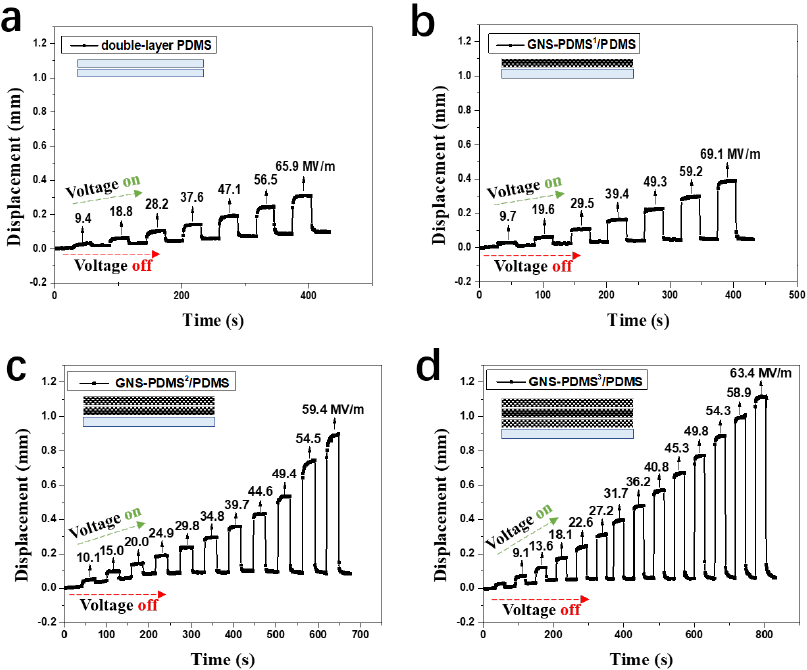
Figure 5. Actuated displacement as a function of time and electric field intensity: ( a ) Double-layer polydimethylsiloxane (PDMS); ( b ) GNS-PDMS 1 /PDMS; ( c ) GNS-PDMS 2 / PDMS; and ( d ) GNS-PDMS 3 /PDMS.